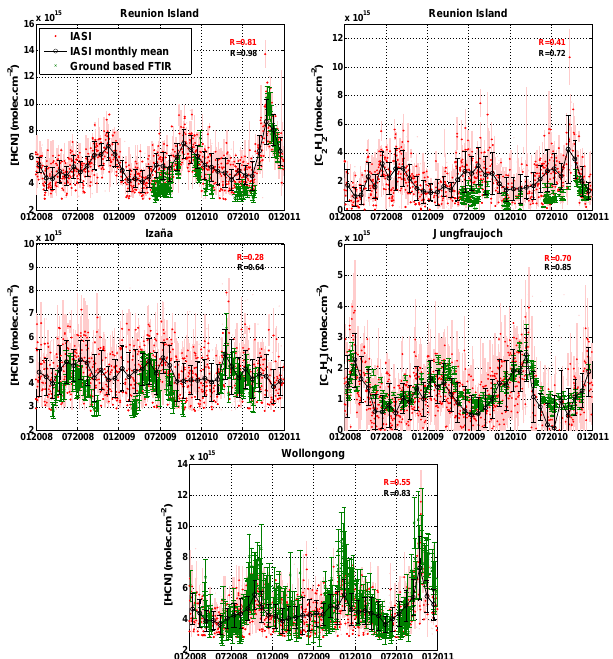
Figure6. TimeseriesofHCN(leftpanel)andC 2 H 2 (rightpanel)measurementsforReunionIsland(HCNandC 2 H 2 ),Wollongong(HCN Figure 8. Time series of HCN (left panel) and C 2 H 2 (right panel) only),Izaña(HCNonly),andJungfraujoch(C 2 H 2 only).IASImeasurementsareshownasdailyand1 ◦ x1 ◦ means(reddots)withassociated standarddeviations(lightredlines),andasmonthlyand1 ◦ x1 ◦ means(blackcirclesandline)withassociatedstandarddeviation(vertical measurements for Reunion Island (HCN and C 2 H 2 ), Wollongong blacklines).Ground-basedFTIRmeasurementsareshownasdailymeanswithassociatedtotalerrorbygreencrossesandlines.Correlation coefficientsaregivenoneachplotfordailymeansinredandformonthlymeansinblack. (HCN only), Izaña (HCN only), and Jungfraujoch (C 2 H 2 only). IASI measurements are shown as daily and 1 ◦ × 1 ◦ means (red are probably due to the 2010 great Amazonian fires [Lewis At Wollongong HCN peaks also in October-November etal.,2011]influence. due to the Southern Hemisphere biomass burning season dots) with associated standard deviations (light red lines), and as [Paton-Walsh et al., 2010]. We find maxima of around 11 415 monthly and 1 ◦ × 1 ◦ means (black circles and line) with associated standard deviation (vertical black lines). Ground-based FTIR mea- surements are shown as daily means with associated total error by green crosses and lines. Correlation coefficients are given on each plot for daily means in red and for monthly means in